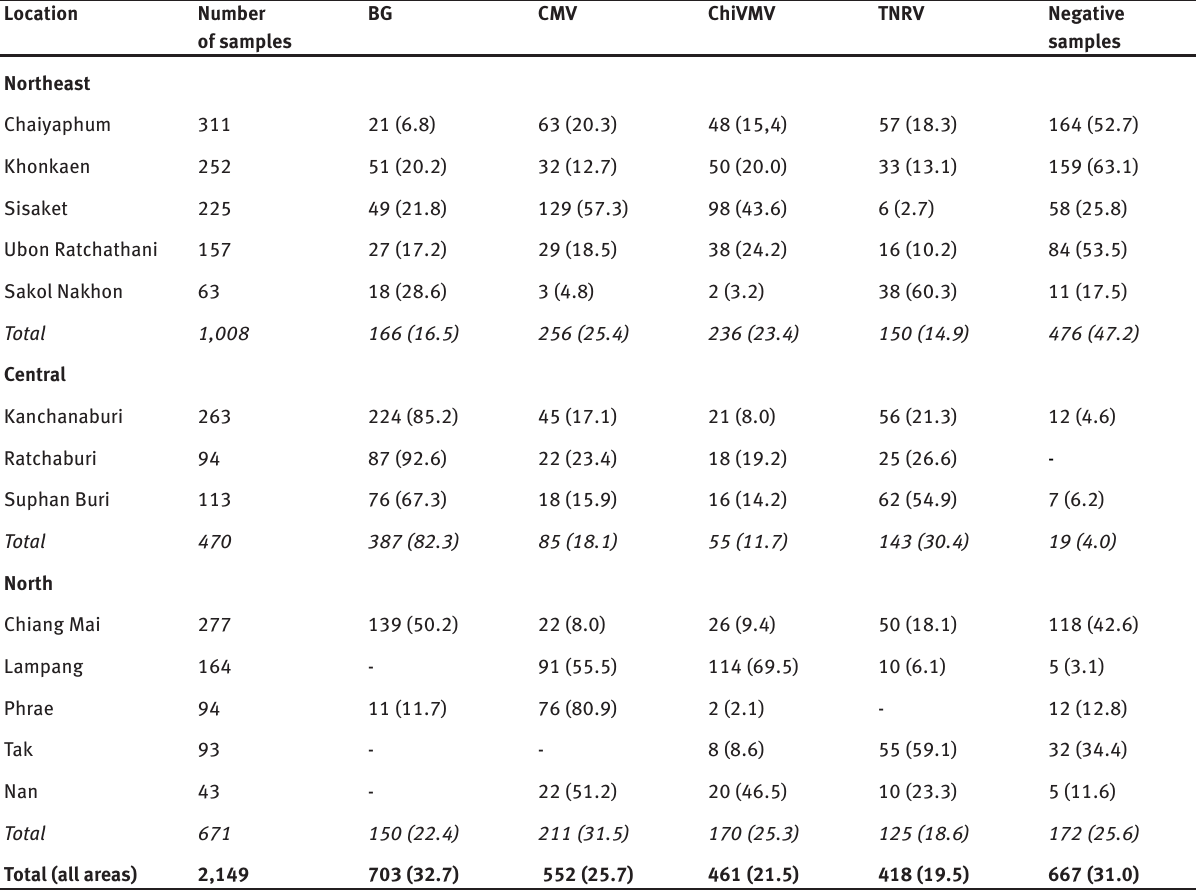
Table 1: Detection of Begomovirus (BG), Cucumber mosaic virus (CMV), Chilli veinal mottle virus (ChiVMV), and Tomato necrotic ringspot virus (TNRV) from diseased pepper leaf samples using ELISA